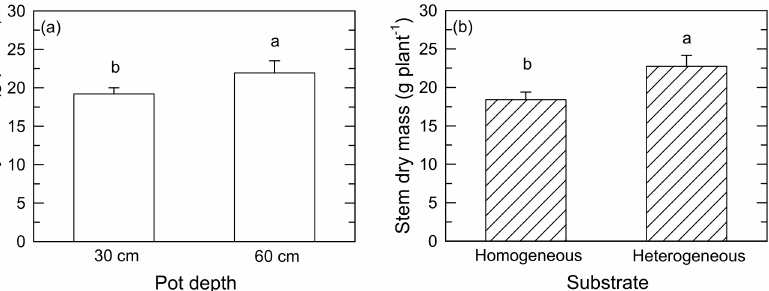
Figure 3. ( a ) Stem dry mass of Populus sibirica seedlings in 30 and 60 cm containers and in ( b ) ho- mogenous and heterogeneous substrates. Different lowercase letters indicate significant differences between substrate heterogeneity treatments or container depth treatments. Vertical bars represent standard errors.